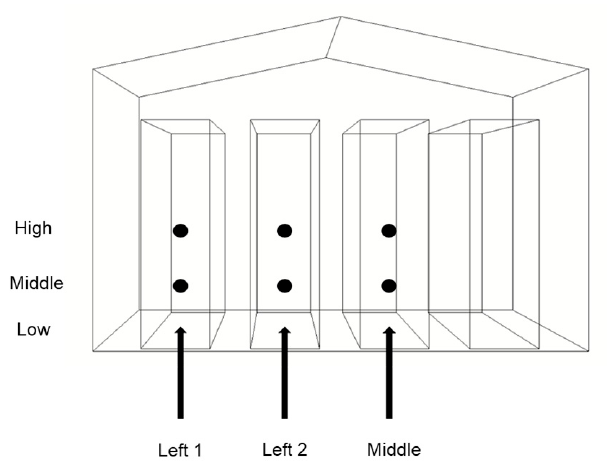
Figure 2. Temperature monitoring in water-pad layer house, Dalin, Chiayi.